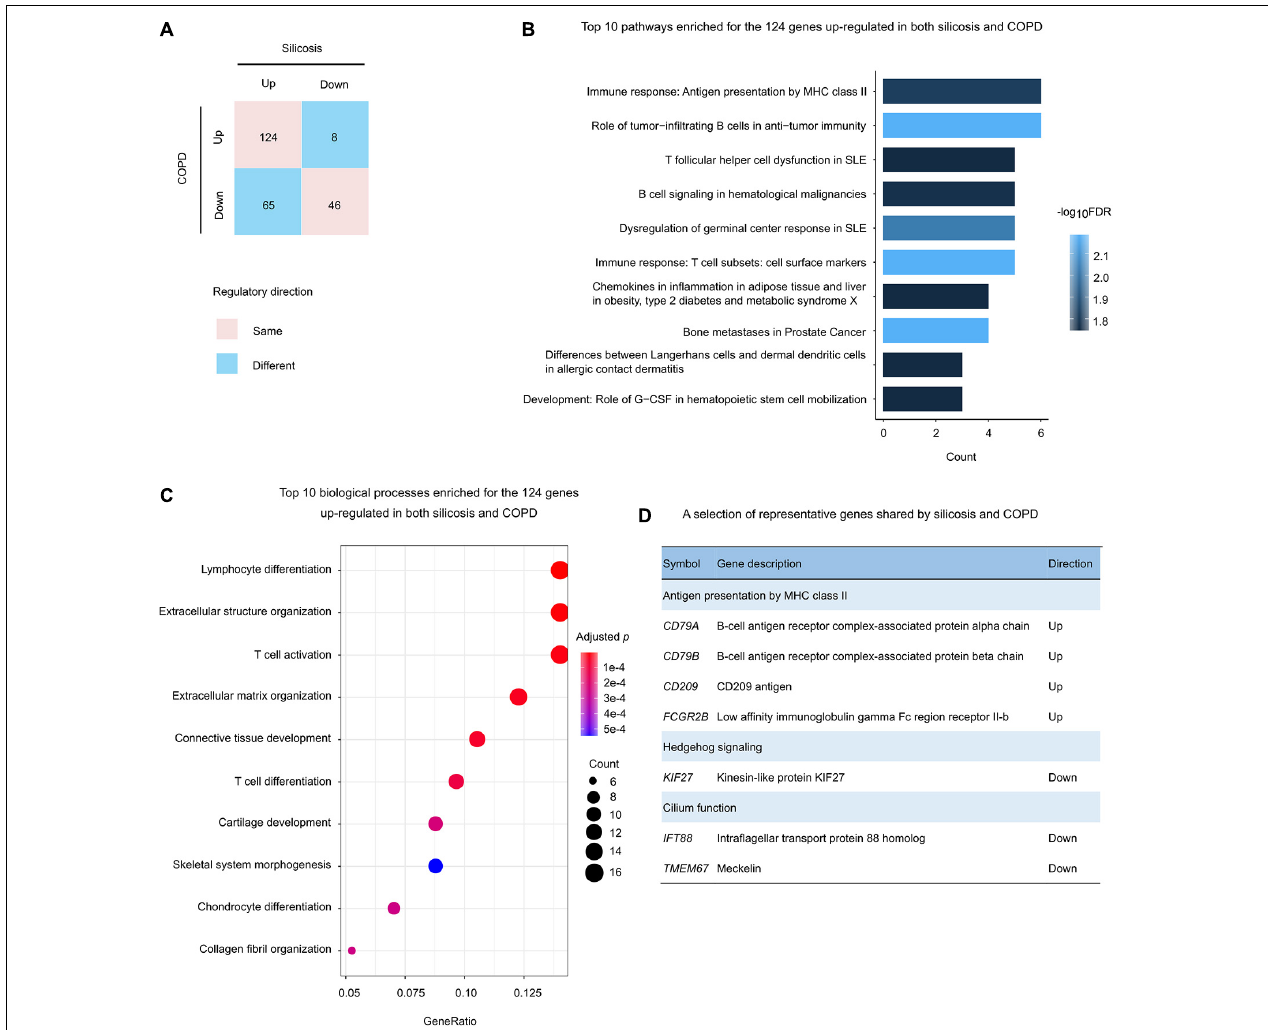
FIGURE 5 | Functional analysis of the genes regulated in both silicosis and COPD. (A) Statistics of the gene counts regulated in both silicosis and COPD. Pink squares indicate genes regulated in the same direction (up or down) in both diseases; blue squares indicate genes regulated in different directions in the two diseases. (B) The top 10 significant pathways enriched for the 124 genes up-regulated in both silicosis and COPD. (C) The top 10 biological processes significantly enriched for the 124 genes up-regulated in both silicosis and COPD. The size of dots reflects the gene counts for each process. Dot color reflects adjusted p -values, where the most significant result is red. (D) Representative genes selected from significant pathways shared by silicosis and